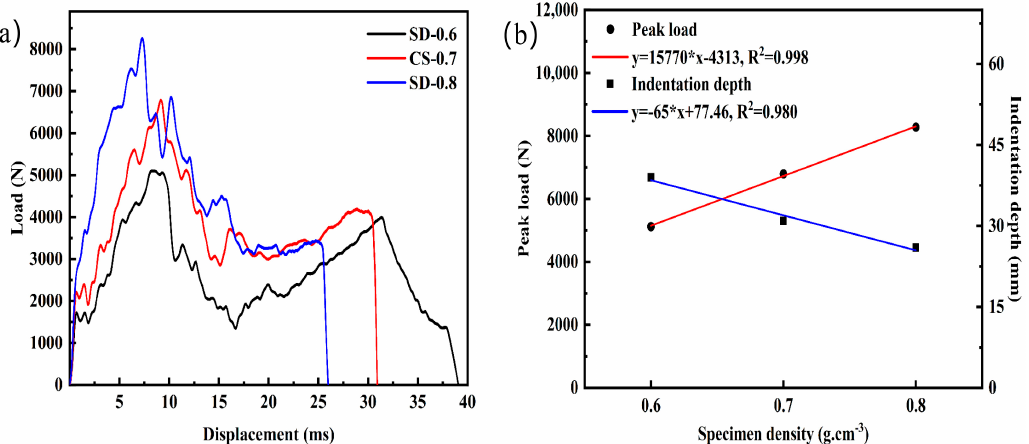
Figure 12. Mechanical response at different densities: ( a ) Load-displacement curves; ( b ) Linear fitting plots of peak load, and the indentation depth at different densities.